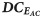
Estimation performance of OBEM on-line updating method (example of DCEAC).